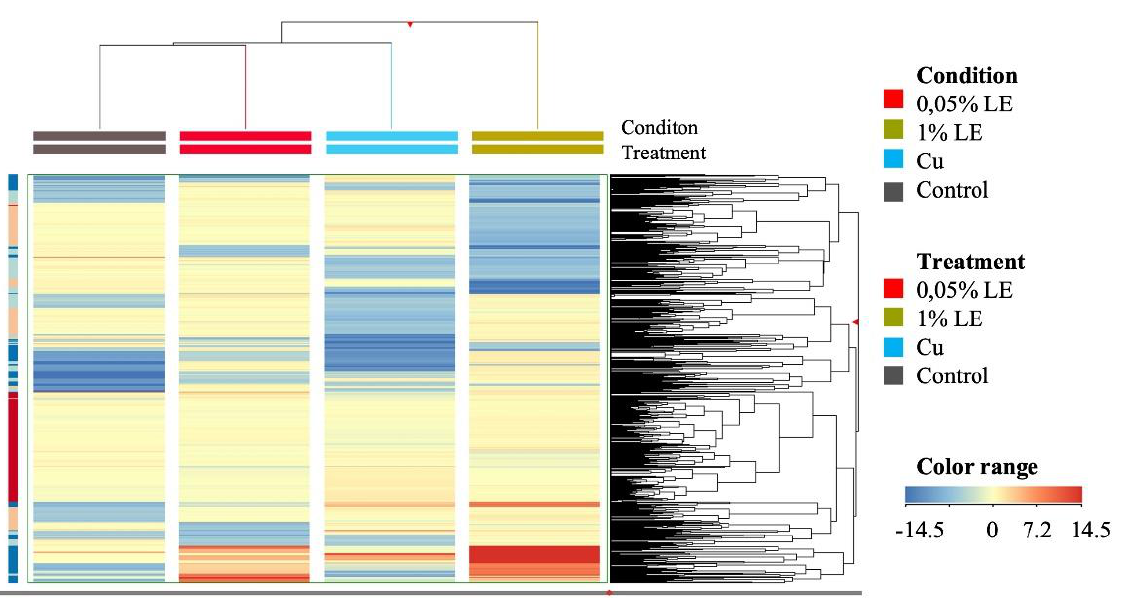
Figure 3. Unsupervised hierarchical cluster analysis carried out from UHPLC-ESI/QTOF-MS metabolomic analysis of maize plants Cu-stressed and treated with Cu + 0.05% LE and Cu + 1.00% LE. The fold-change based heat map was used to build hierarchical clusters (linkage rule: Ward; distance: Euclidean).